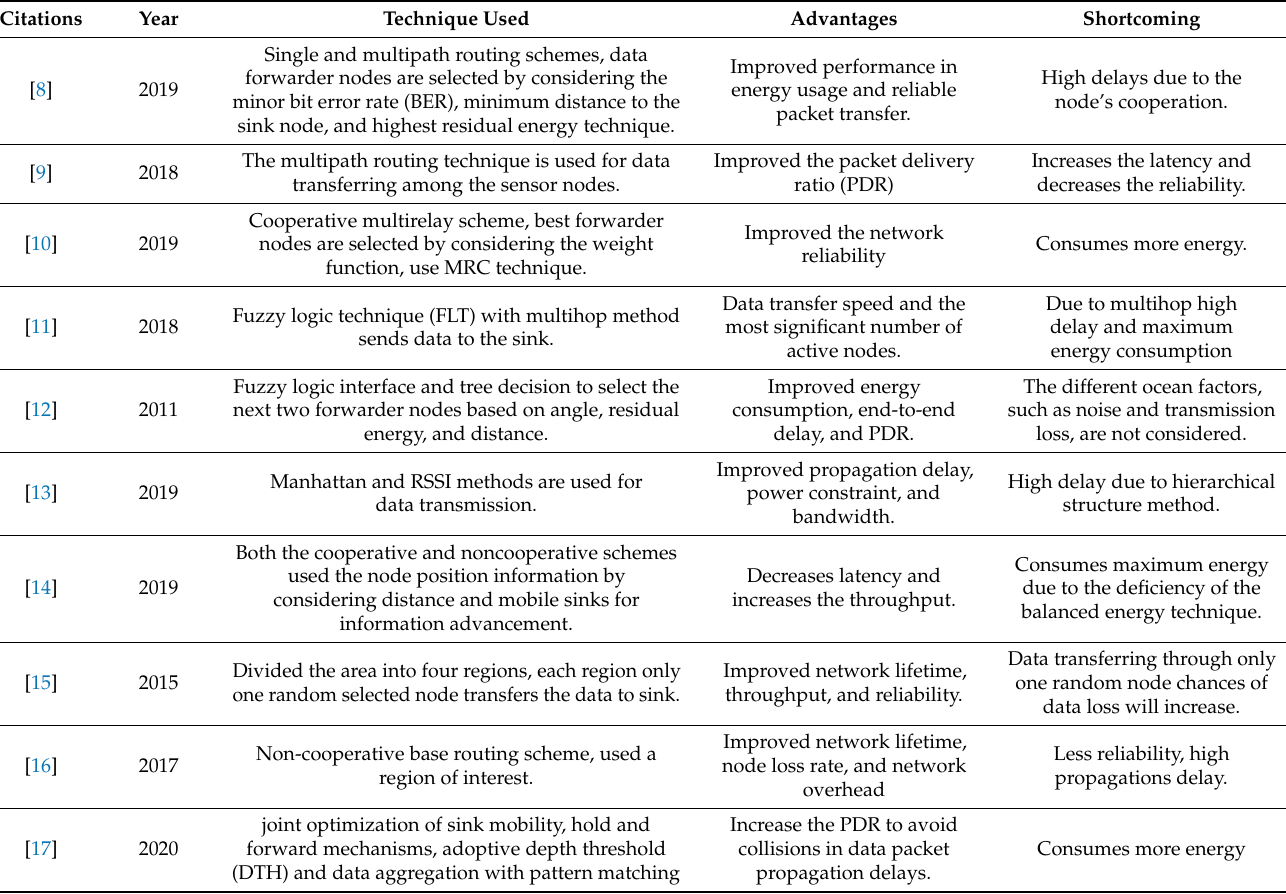
Table 1. Overview of the recently published